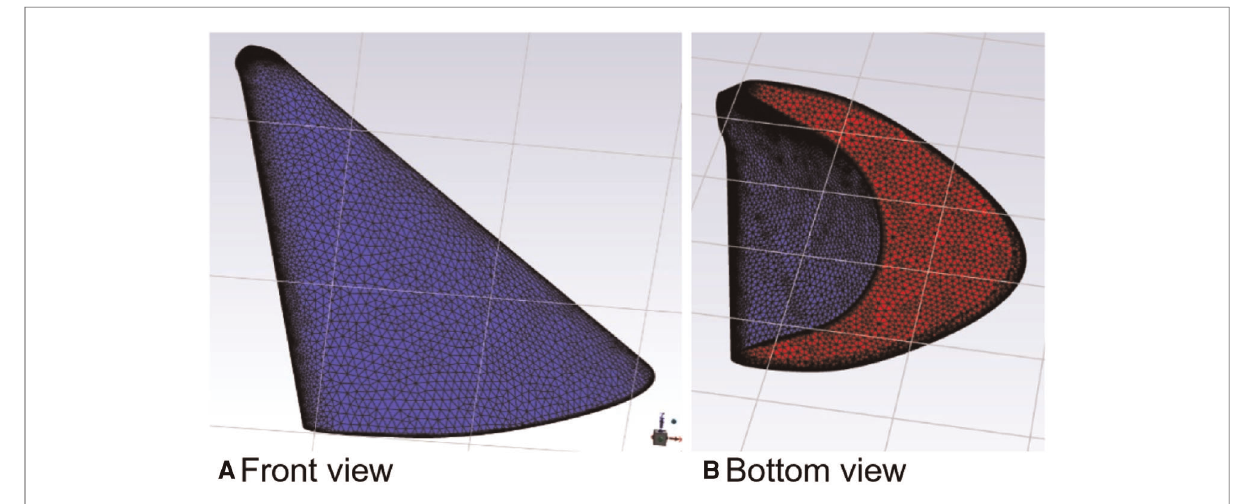
FIGURE 8 Straight model of the curved